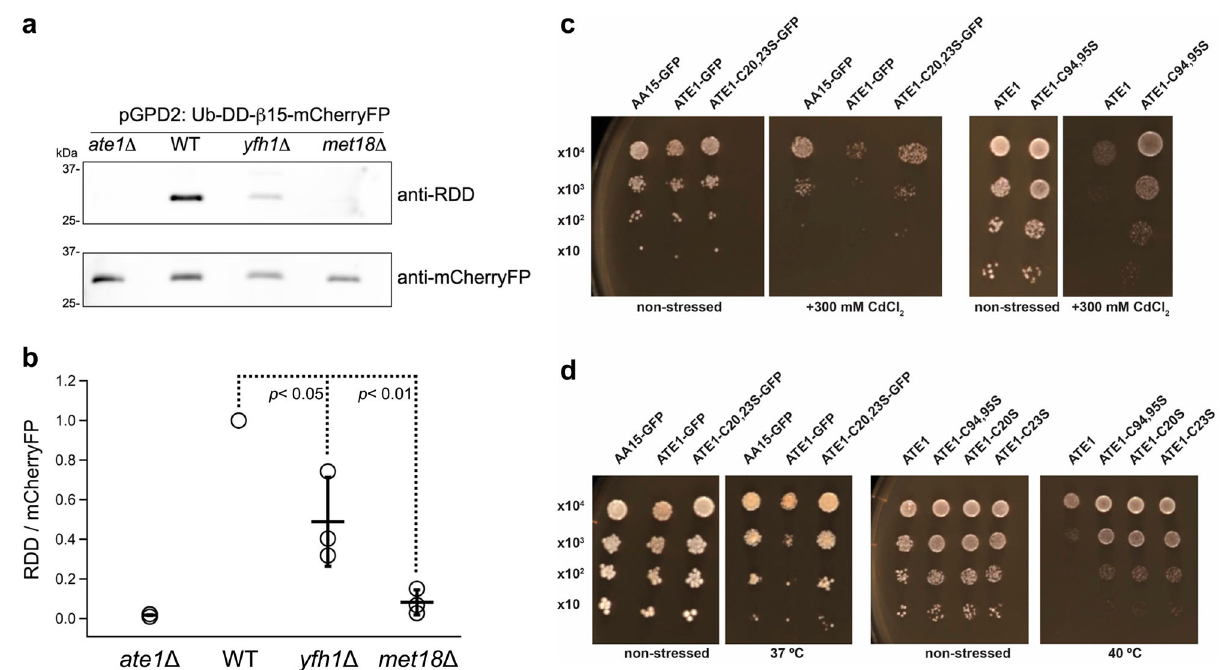
Fig.5|The[Fe-S]clusterbiogenesismachineryislinkedtoinvivoarginylation, and alteration of the ATE1 [Fe-S] cluster-binding capacity affects the yeast stress response. In panels a , b , the yfh1 Δ and met18 Δ S. cerevisiae carry the argi- nylation reporter (Ub-DD- β 15-mCherryFP), while the wild-type and ate1 Δ yeasts were also transformed as positive and negative controls. In panel a , the signal of arginylated DD- β 15 peptide is detected by an antibody speci fi cally recognizing the N-terminalRDDresidues.Thetotallevelofthereporterproteinwasmeasuredbyan antibody recognizing mCherryFP. Representative images ( n =3 independent yeast growths) in panel a show the signalsdetected byanti-RDD and anti-mCherryFP.To avoid signal cross-over, the detections of RDD and mCherryFP were performed on separate membranes with identical loading volumes. Panel b shows the ratio between RDD and mCherryFP ( n =3 independent yeast growths represented by opencircles,theaverageindicatedbyahorizontalbar,anderrorbarsrepresenting ±1 standard deviation of the mean). Statistical signi fi cance was calculated by the Student ’ s t -test (two-sided ANOVA) and p <0.01 was considered highly signi fi cant.